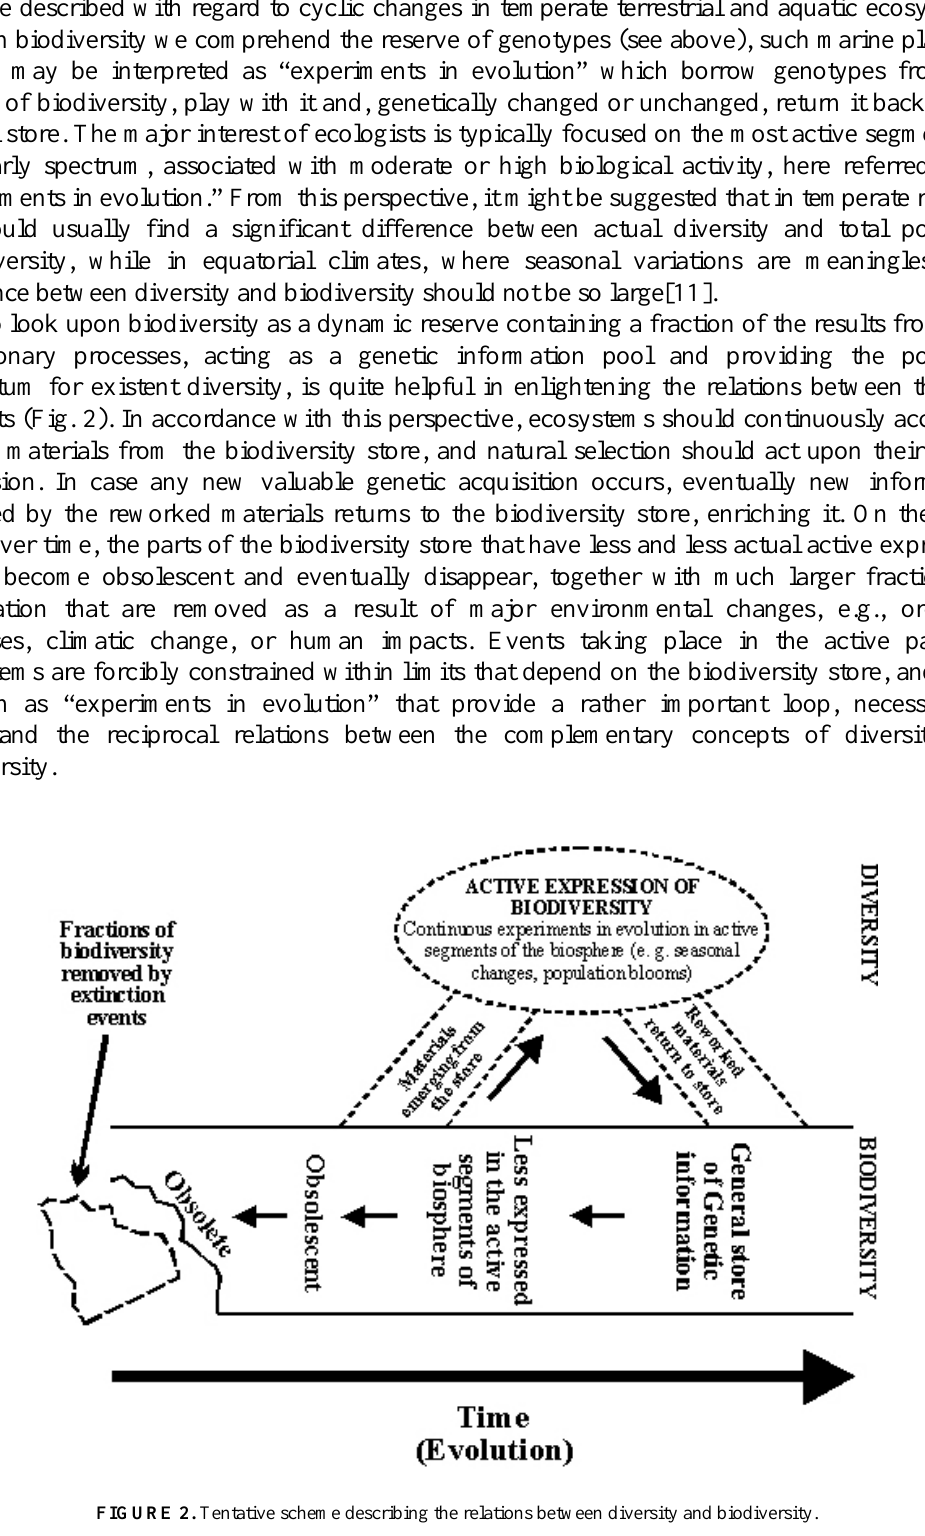
FIGURE 2. Tentative scheme describing the relations between diversity and